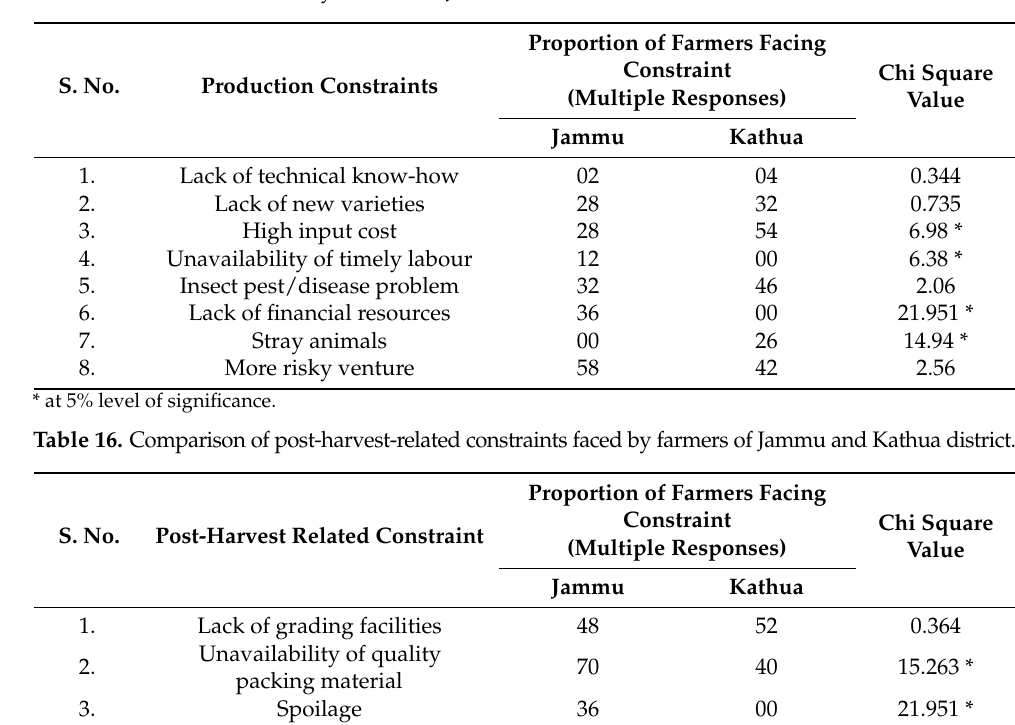
Table 15. Constraints faced by farmers of Jammu and Kathua district.